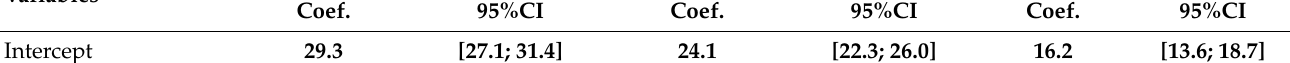
Table 3. Multiple linear regression analysis results for the final model for TISS-28 (first) and TISS28 (last)-VA and TISS28 (last)-VB. In bold are presented the significant results. TISS-28 (First) ( n = 728) TISS-28 (Last)-VA ( n = 633) TISS-28 (Last)-VB ( n = 633)